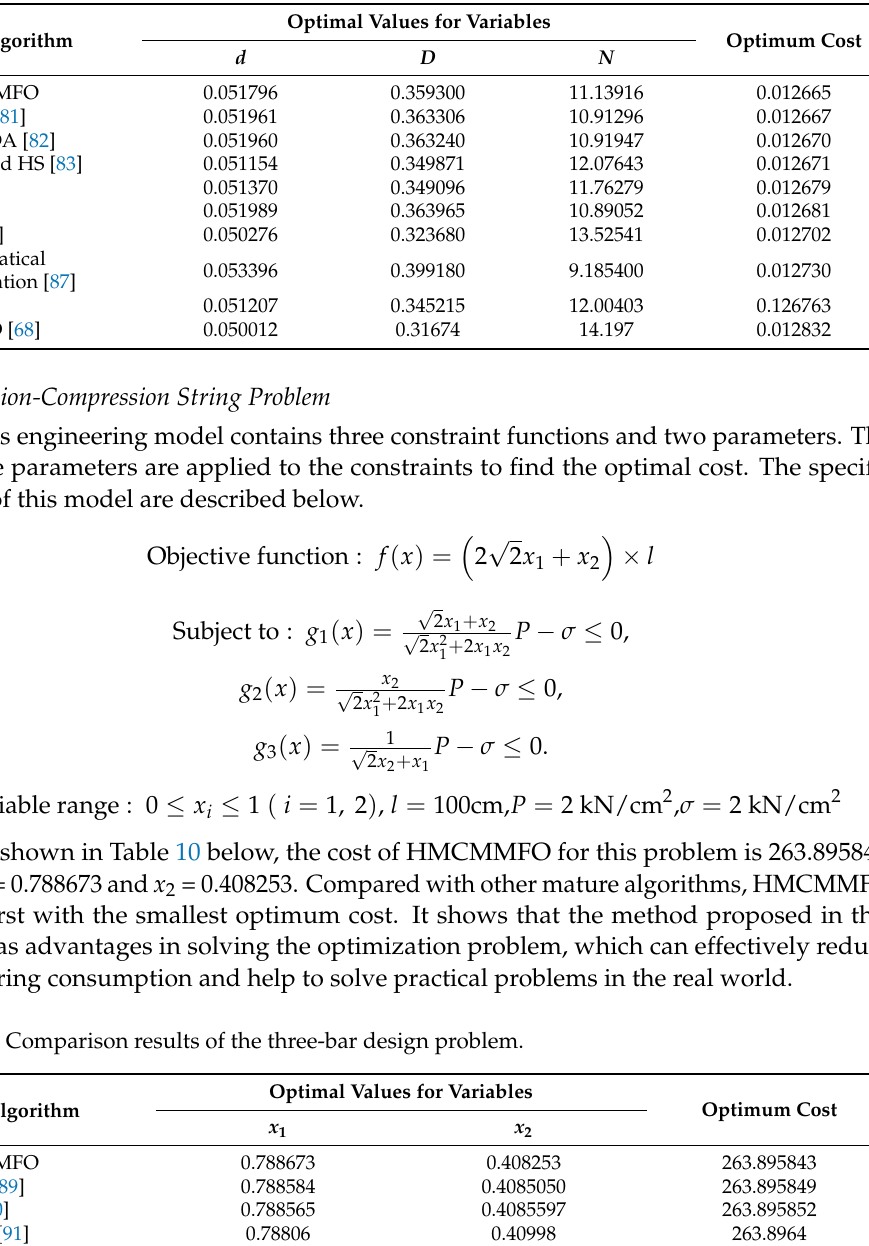
Table 9. Comparison results of the tension-compression string problem.